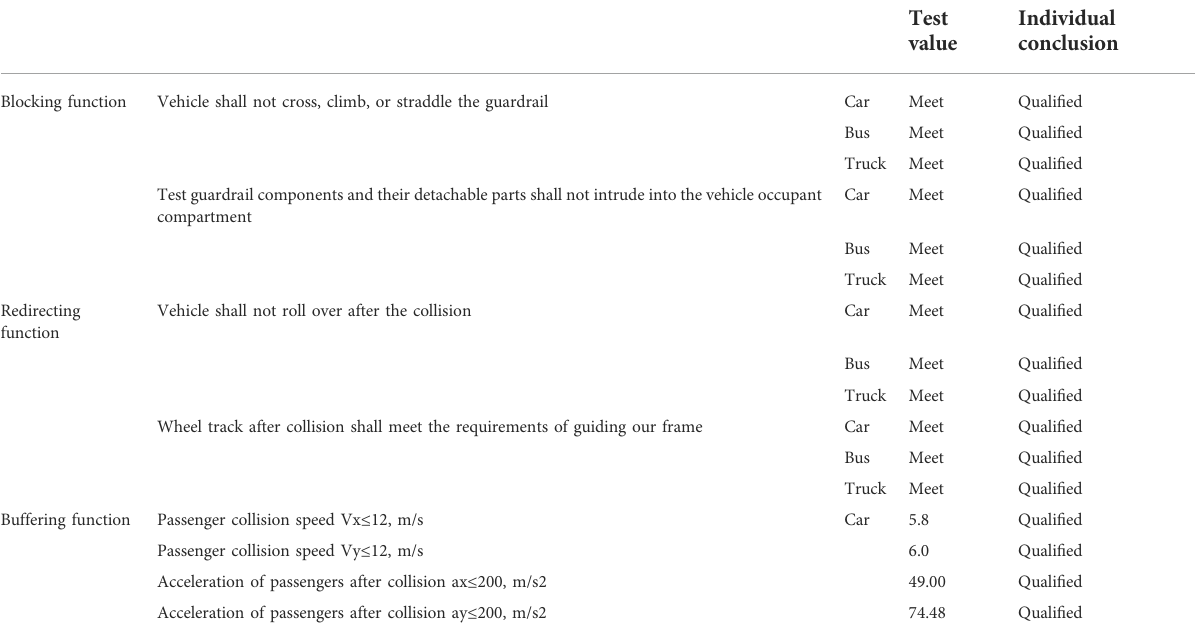
TABLE 1 Crash test